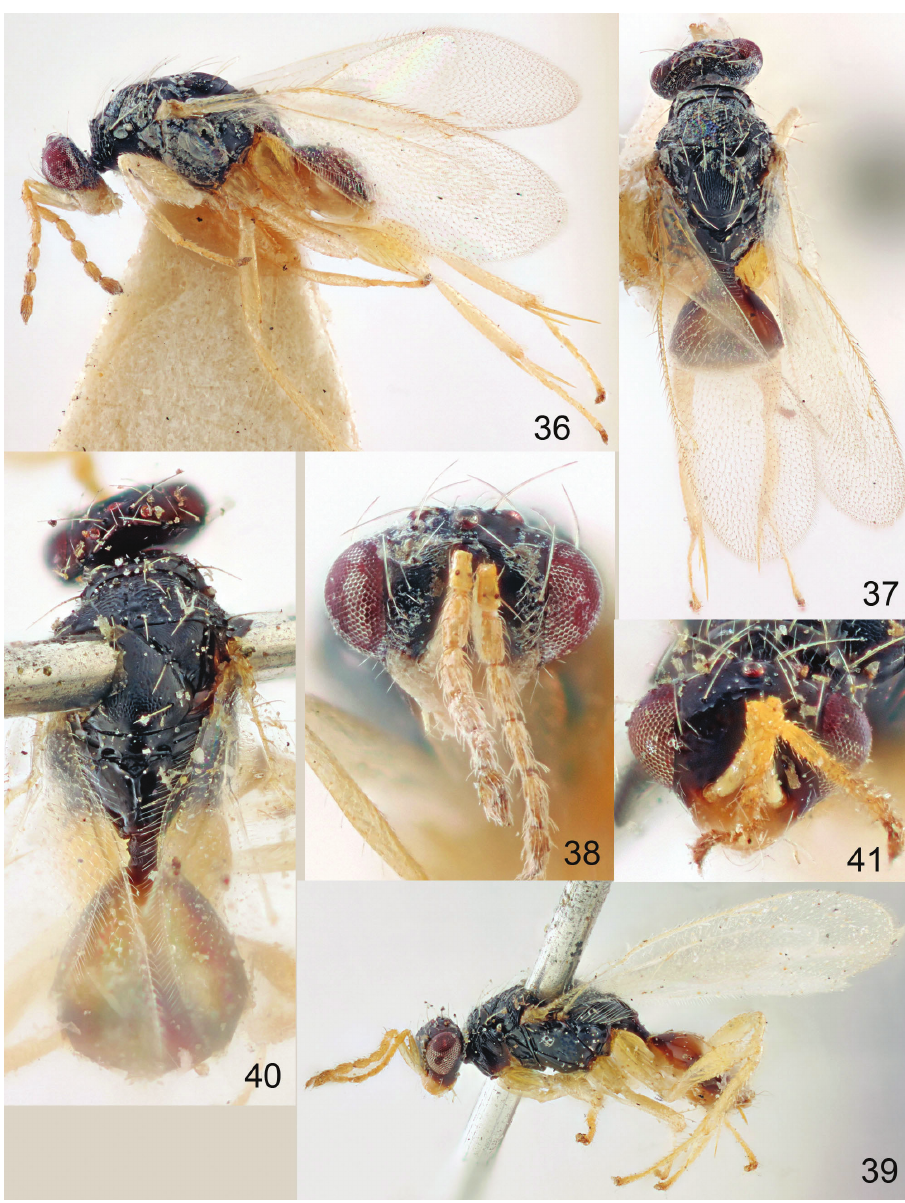
Figures 36–41. Euplectrus spp.: 36–38 E. liparidis Ferrière, holotype female 36 habitus lateral 37 habi- tus dorsal 38 head frontal 39–41 E. phthorimaeae Ferrière, holotype female 39 habitus lateral 40 habitus dorsal 41 head